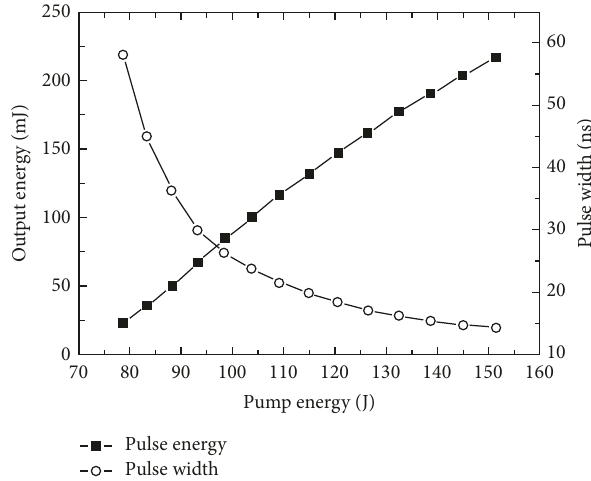
Figure 6: Output energy and pulse width as a function of pump energy in LGS EO Q-switched Cr,Er:YSGG laser. Reprinted with permission from [20]. Copyright 2013 Optical Society of